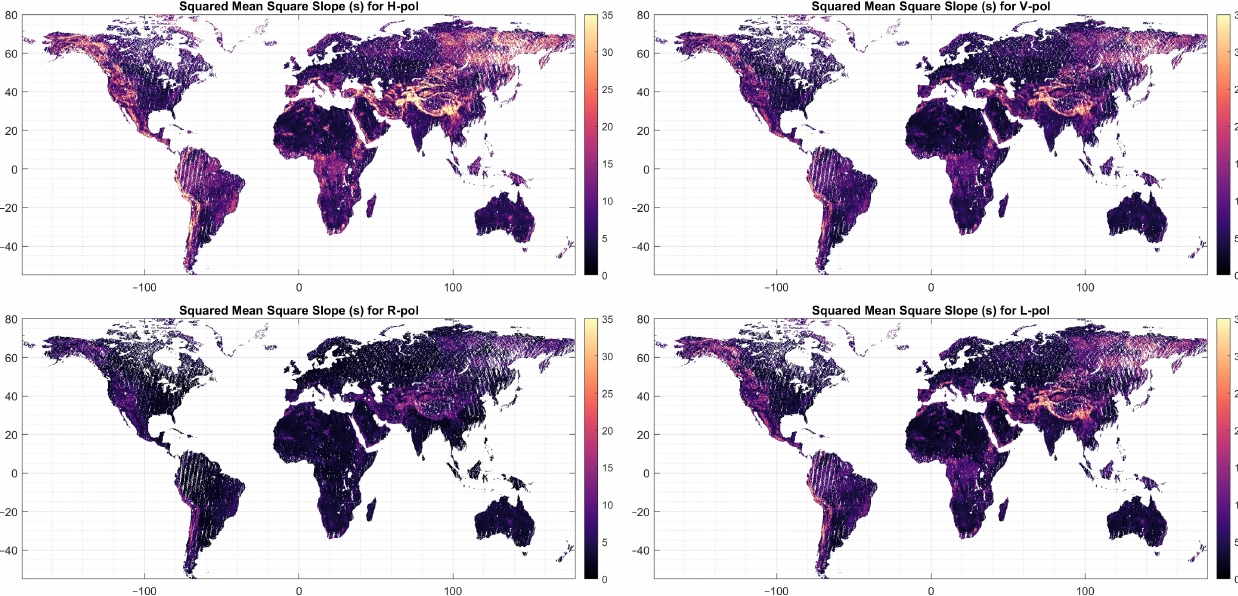
Figure 3. Surface slope rms or squared mean square slope (s) for each polarization H, V, R, L. s is unitless.